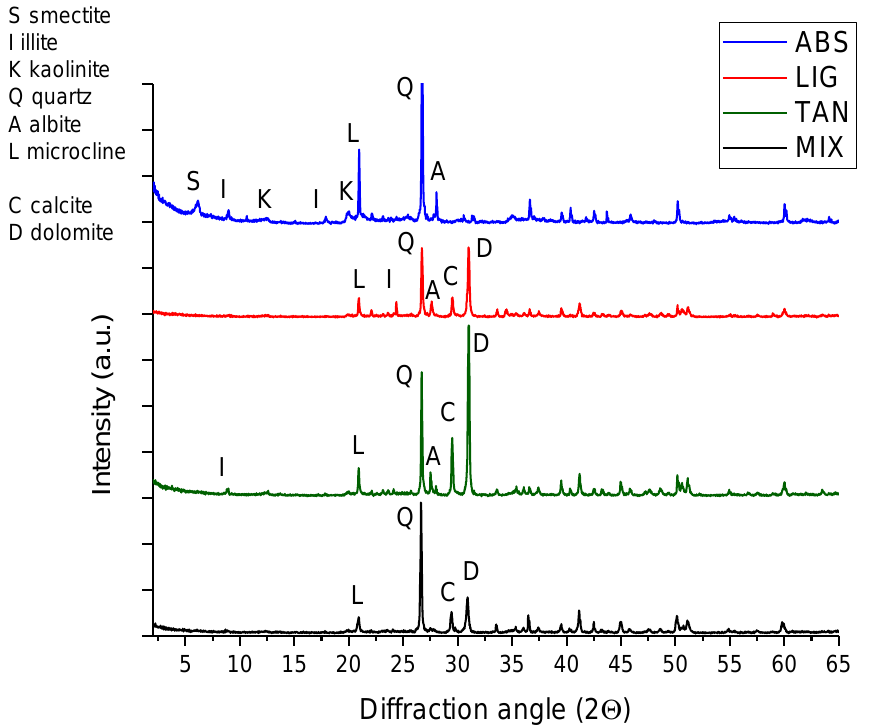
Figure 9. XRD diffraction pattern for ABS soil, MIX, and the stabilized mixtures: TAN and LIG. In the diffraction patterns of MIX, LIG and TAN, calcite (29.1 ◦ 2 θ ) and dolomite (30.9 ◦ 2 θ ) are visible, due to the addition of calcareous sand to ABS [67]. Conversely, the clay peaks appear reduced or had disappeared as compared to ABS spectrum, because the high quantity of sand reduces the relative percentage of clay. The illite and albite peaks are still visible in the LIG and TAN patterns; conversely, they disappeared in MIX,